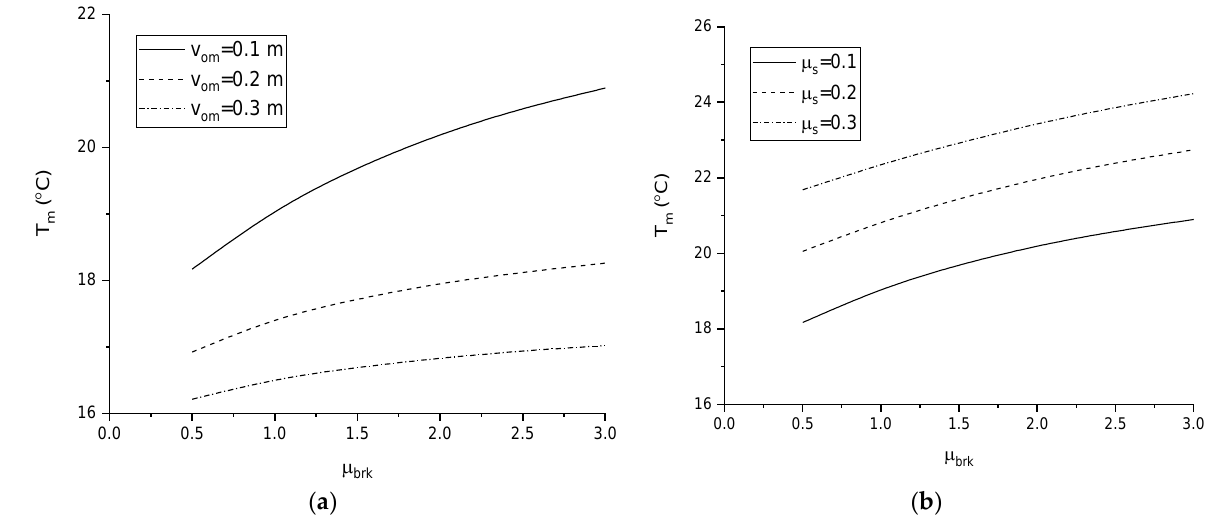
Figure 9. ( a ) Influence of 𝜇 𝑏𝑟𝑘 on 𝑇 𝑚 with different 𝑣 𝑜𝑚 ( 𝜇 𝑠 = 0.1 ). ( b ) Influence of 𝜇 𝑏𝑟𝑘 on 𝑇 𝑚 with different 𝜇 𝑠 . ( 𝑣 𝑜𝑚 = 0.1 m).